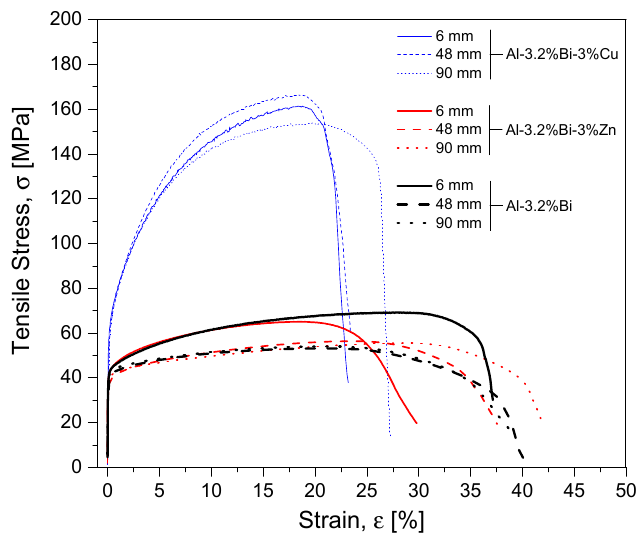
Figure 7. Stress-strain curves of tensile testing for the Al-3.2 wt.% Bi, Al-3.2 wt.% Bi-3.0 wt.% Zn, and Al-3.2 wt.% Bi-3.0 wt.% Cu alloys. Figure 8 depict wear resistances (WR = 1/V) related to sliding distances of 798 m and 1197 m, respectively, as a function of λ Bi for the Al-3.2 wt.% Bi, Al-3.2 wt.% Bi-3.0 wt.% Zn, and Al-3.2 wt.% Bi-3.0 wt.% Cu alloys. It is quite clear noting that the wear resistance